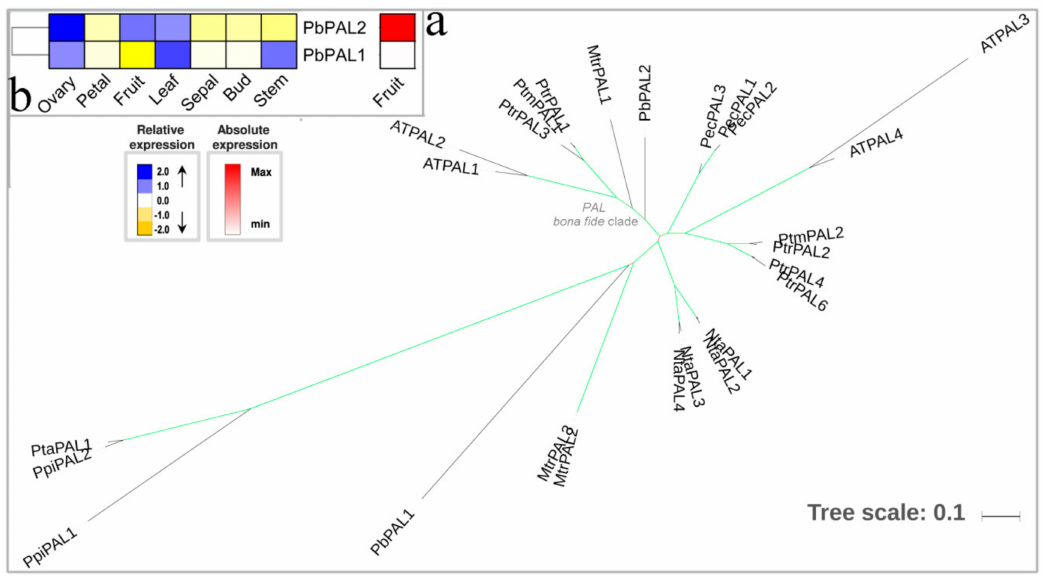
Figure 1. Phylogenetic tree and expression profiles of the PAL bona fide clade. ( a ) ML tree built with PAL bona fide enzymes from several species. ( b ) The expression profiles P. bretschneideri PAL bona fide genes. The green color of the tree branches suggests strong node support (bootstrap support ≥ 95% and SH-aLRT ≥ 75%). The FPKM values of PbPAL genes in di ff erent tissues are indicated in Table S3. The gene accession number is indicated in Table S4. The tree scale is the number of amino acid substitution per